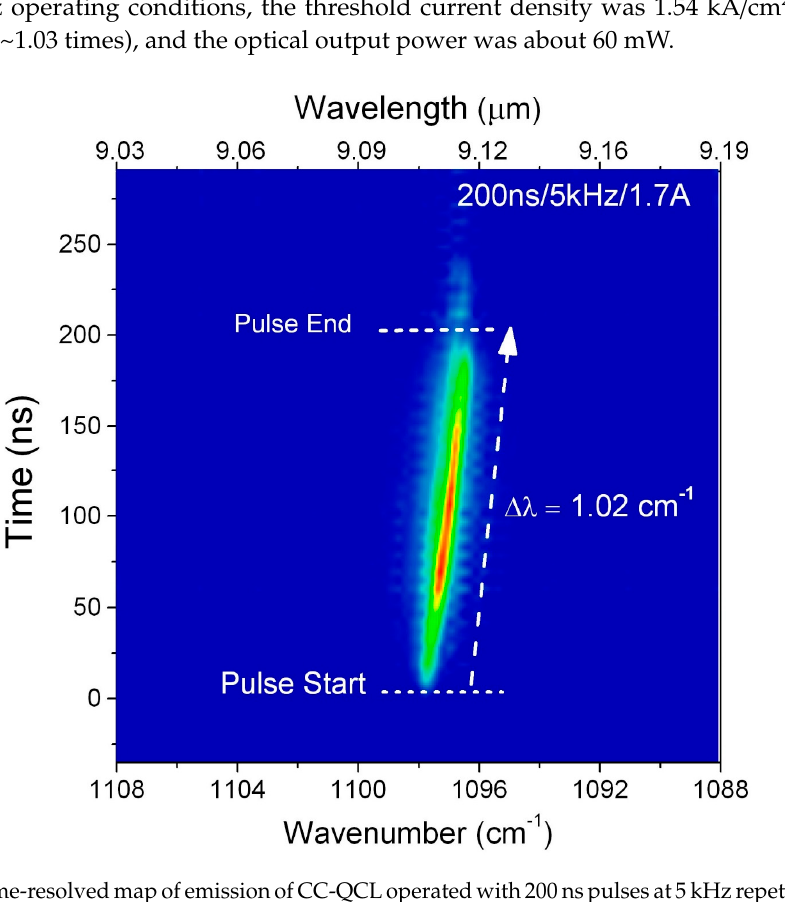
Figure 10. Normalized ( a ) and non-normalized ( b ) emission spectra extracted from the time resolved map registered for CC-QCL operated with 200 ns pulses at 5 kHz repetition rate. The black line presents the spectrum recorded in rapid scan mode of FTIR at the same experimental conditions.